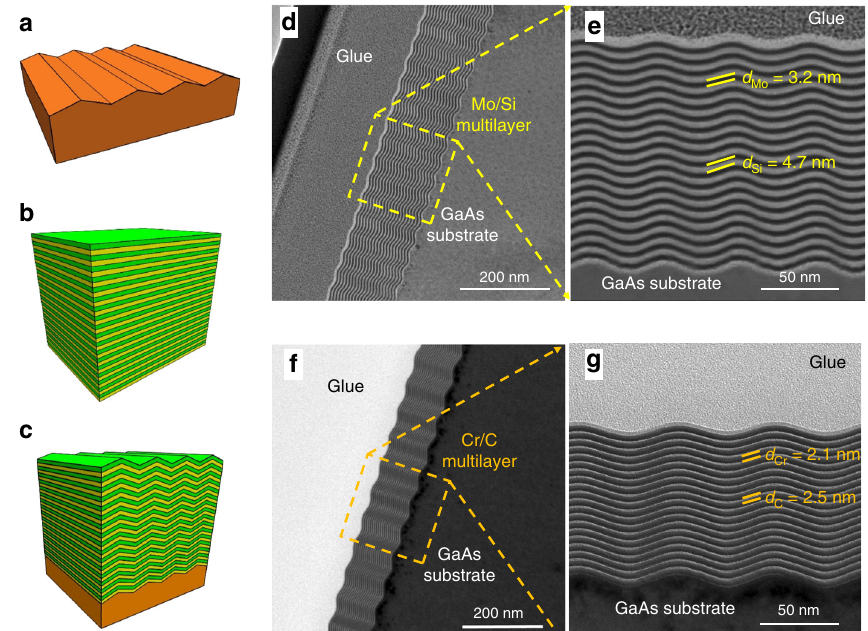
Fig. 2 Fabrication of multilayer blazed gratings. Schematic of the ( a ) bare nanogrooved substrate, ( b ) multilayer, and ( c ) multilayer grating. Cross-section TEM images of the nanograting coated with Mo/Si multilayers ( d , e ) and Cr/C multilayers ( f , g